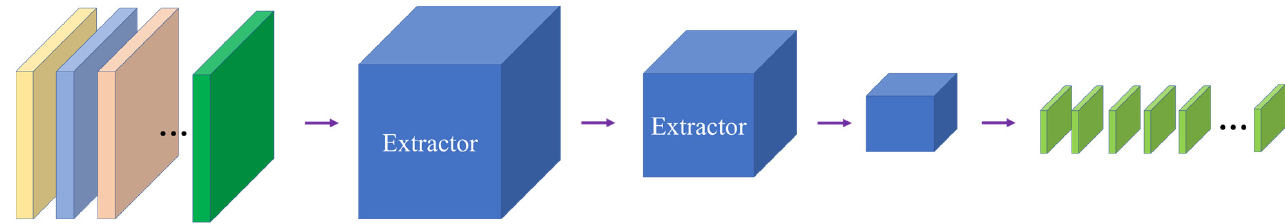
Figure 3. The structure of the Extractor module. 3.2.2. Decoder Network The decoder network is constructed to generate a saturation field and pressure field according to the hidden features calculated by the encoder part above. The entire network contains 3 functional modules, namely the generator module, the model distillation mod- ule [36] and the GRU module [37], as shown in Figure 4. To be specific, the generator module restores the size to the original size. Then, the distillation module accomplishes